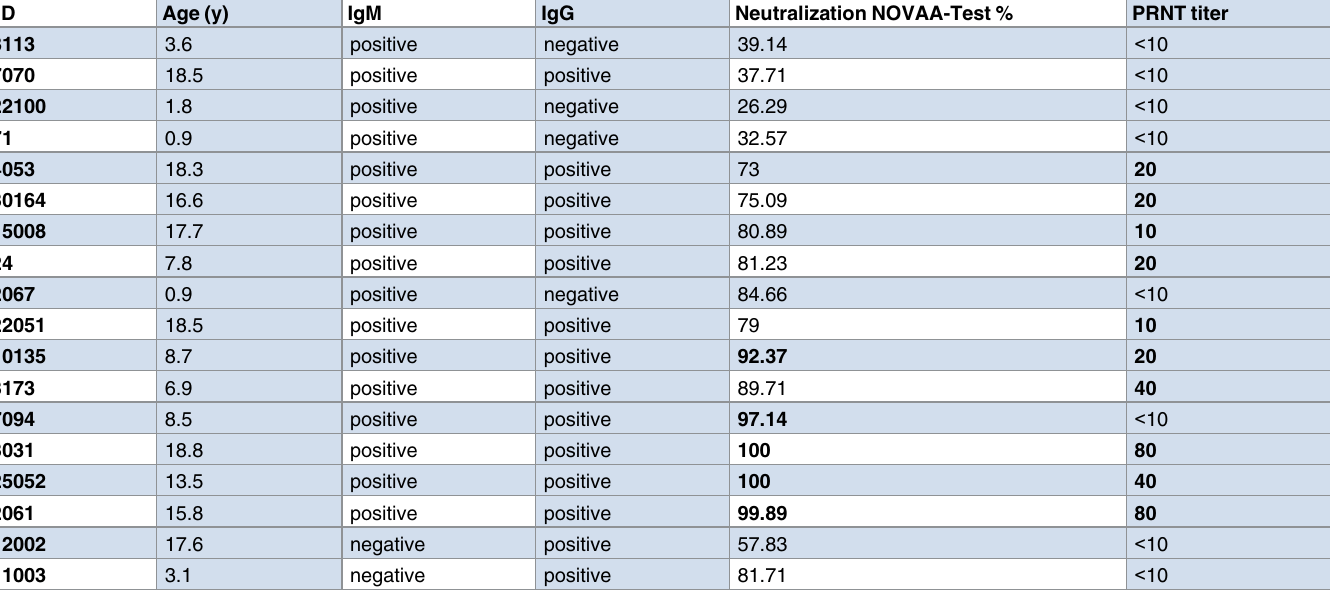
Table 3. NOVAA-test and PRNT values for 18 stored sera collected during acute clinical Dengue in hospitalized children, West French Indies.